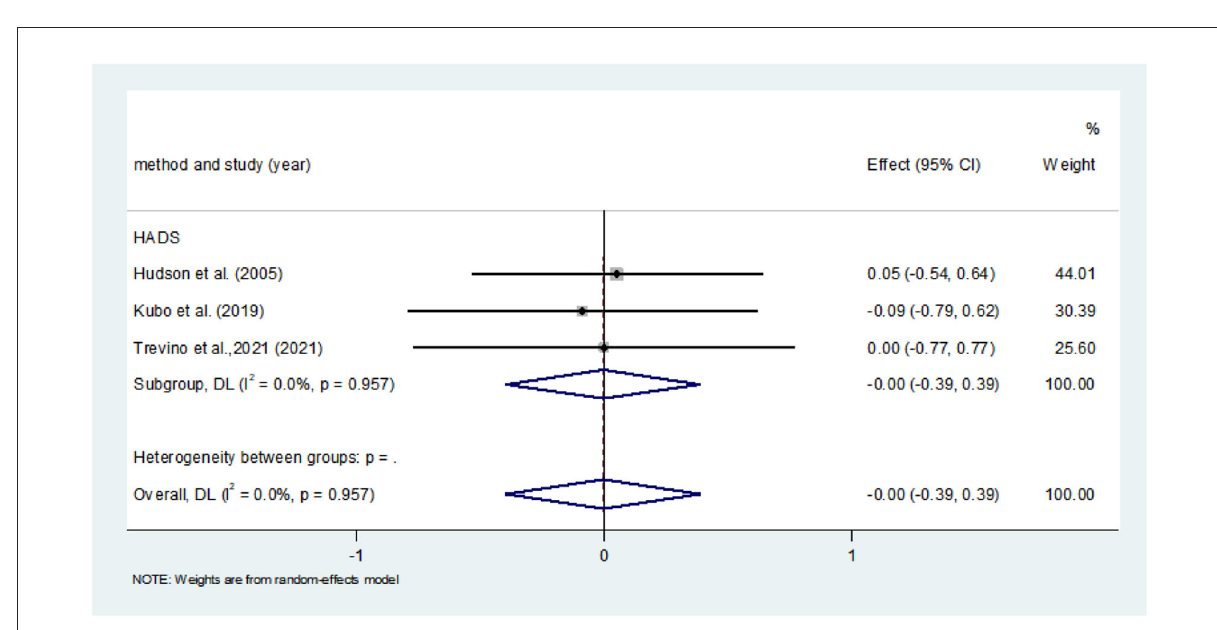
FIGURE11 Forest map for estimating the effect size of anxiety in CQOL-C subgroup [excluding Xiu et al. (32)].